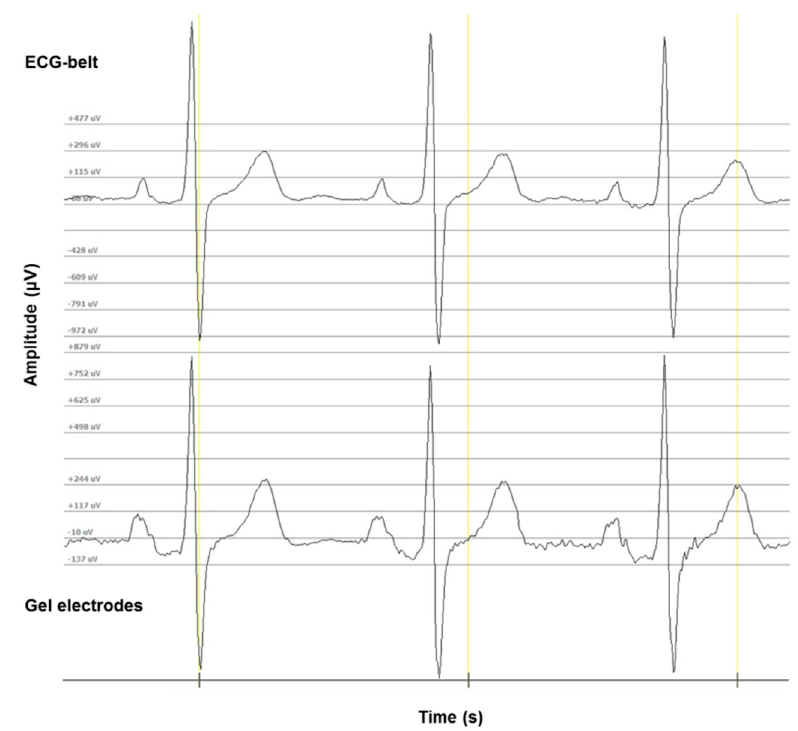
Figure 2. A representative sample of ECG waveforms for gel electrodes and the ECG-belt.